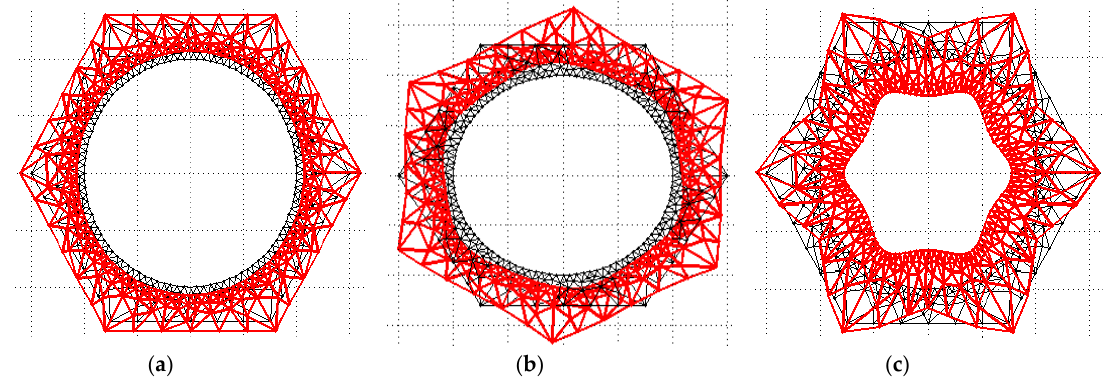
Figure 6. Hexagonal drill pipe’s mode shape : ( a ) L(0,1) mode; ( b ) T(0,1) mode; and ( c ) L(0,2) mode.